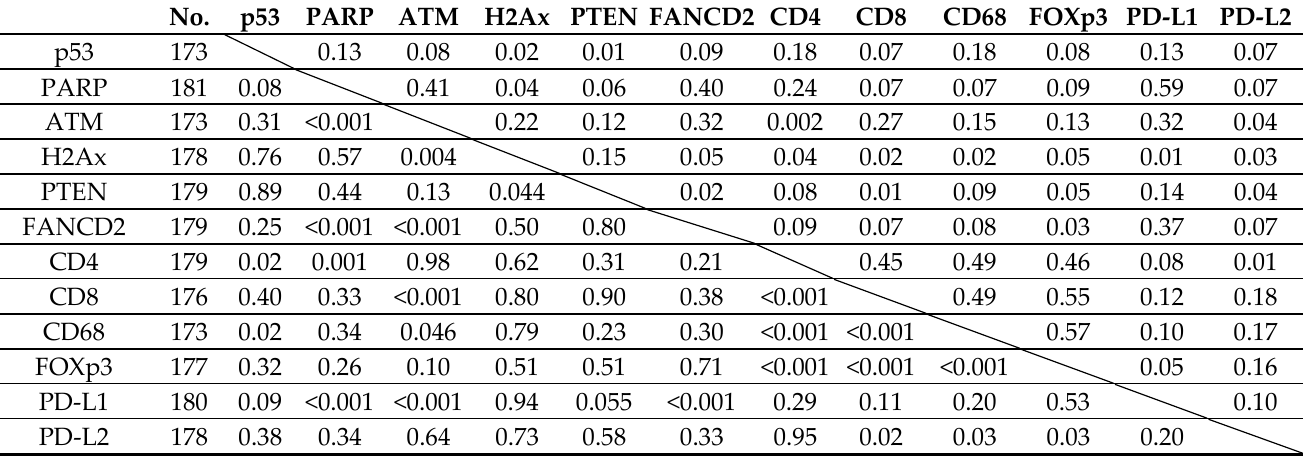
Table 3. Correlation analysis for biomarkers.